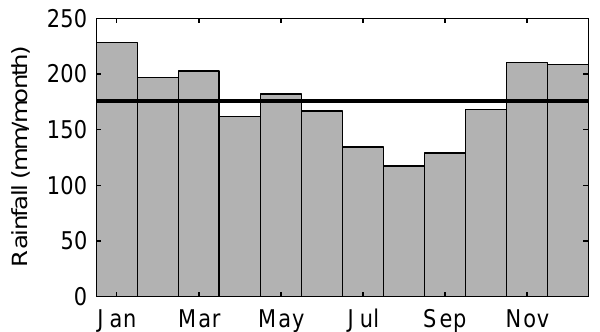
Fig. 2. Monthly rainfall at Tanjung Redeb based on the years 1987– 2007. The annual average is 2105mmyr − 1 , which corresponds to an average monthly rainfall indicated by the thick line.